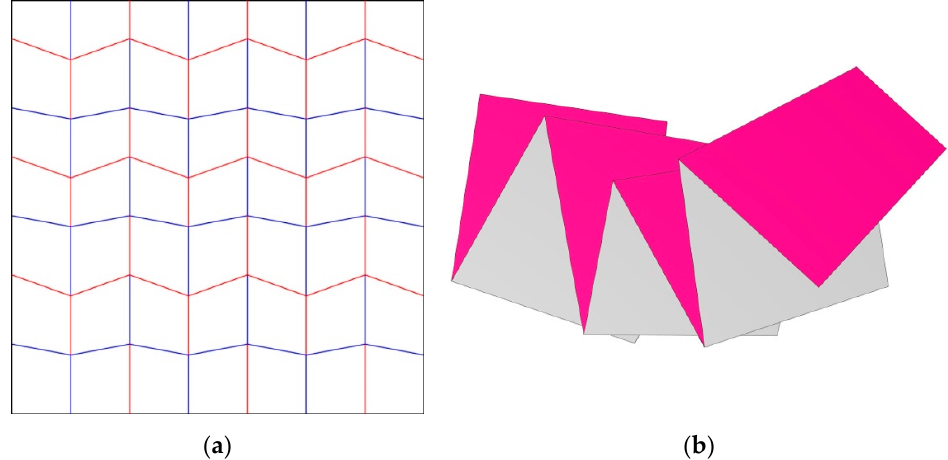
Figure 8. The folding pattern #206 is presented in ( a ) with its folded state in ( b ), where the curvature of the folded state can be observed. (The Origami Simulator, built by Amanda Ghassaei and accessible online, was used to produce this image, http://apps.amandaghassaei.com/OrigamiSimulator/).